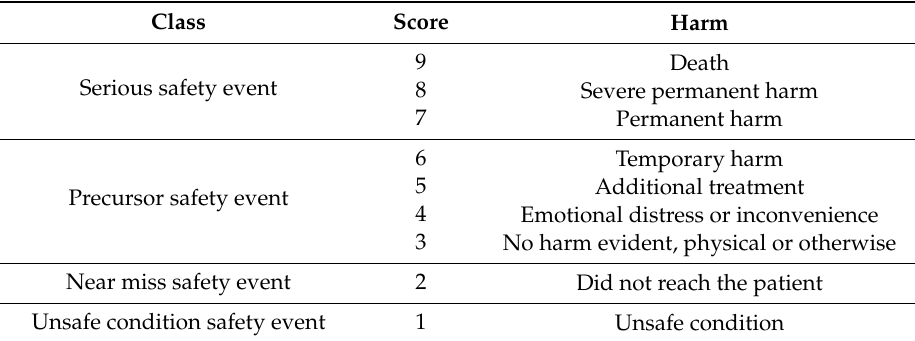
Table 1. Harm score